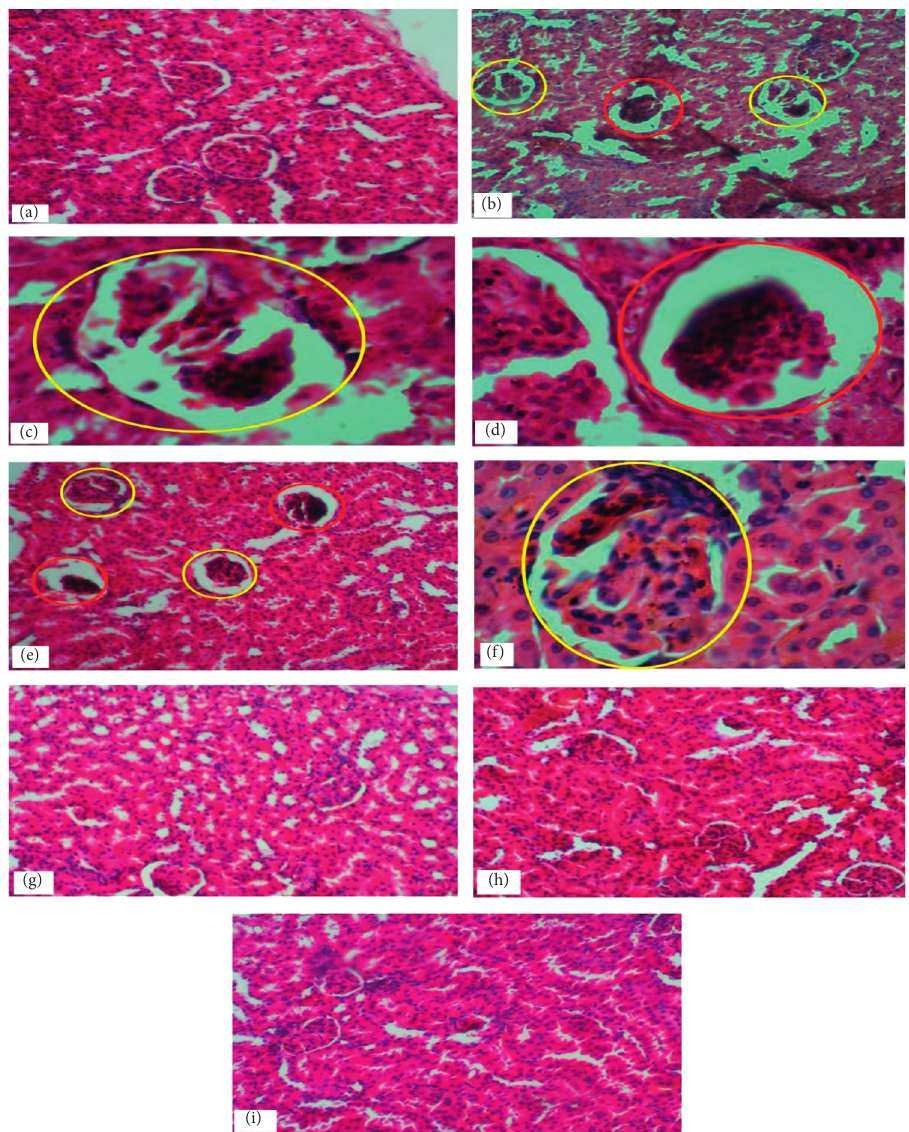
Figure 2: Cross sections in the cortex of the kidney stained with H&E. (a, b) Renal tissue of the control group demonstrating normal appearance of glomerular tuft, urinary space, Bowman’s capsule, proximal tubules, and distal tubules with their nuclei. (b, c) Renal tissue of Cu only treated rat showing disruption of Bowman’s capsule accompanied with acute cortical necrosis (red circle) and shrinking and degeneration of glomeruli (yellow circle). (d) Renal tissue of Pb only treated rat showing evidence of disrupted Bowman’s capsule ac- companied with acute cortical necrosis. (e, f) Renal tissue of both Cu and Pb recovery group rats, respectively, showing evidence of milder form of shrinking and degeneration of glomeruli (yellow circle) and severe disruption of Bowman’s capsule accompanied with acute cortical necrosis. (g–i) Renal tissue of rat treated with heavy metals +100mg, 200mg, and 300mg of EEVA, respectively, showing improvement in glomerular tuft and renal tubules, with normal Bowman’s capsule histoarchitecture (mic. mag. (a, b, e, g, h, i) × 100; (c, d, f) ×